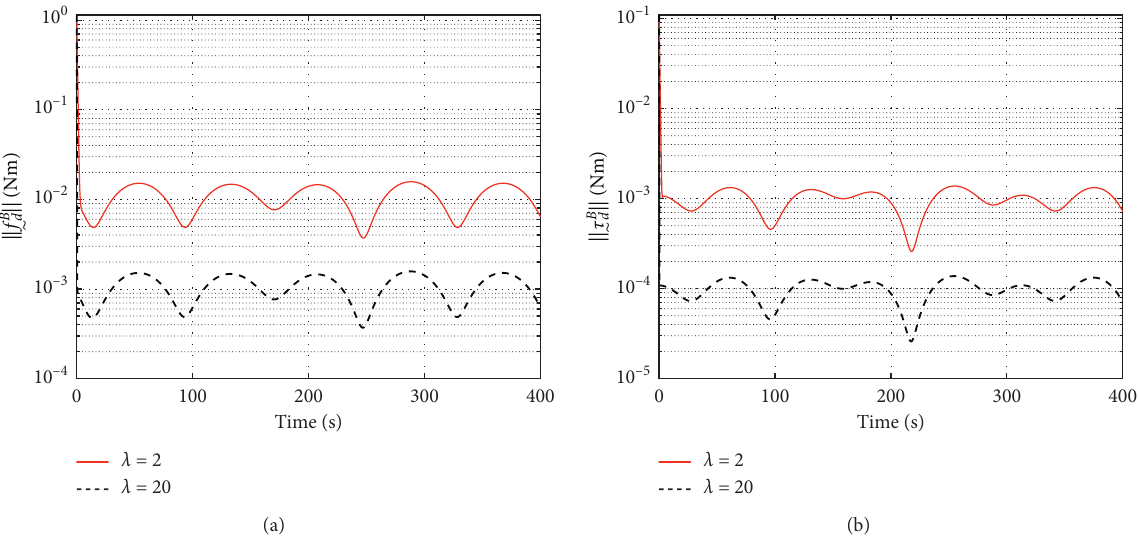
Figure 15: Disturbance estimation error norms with different λ